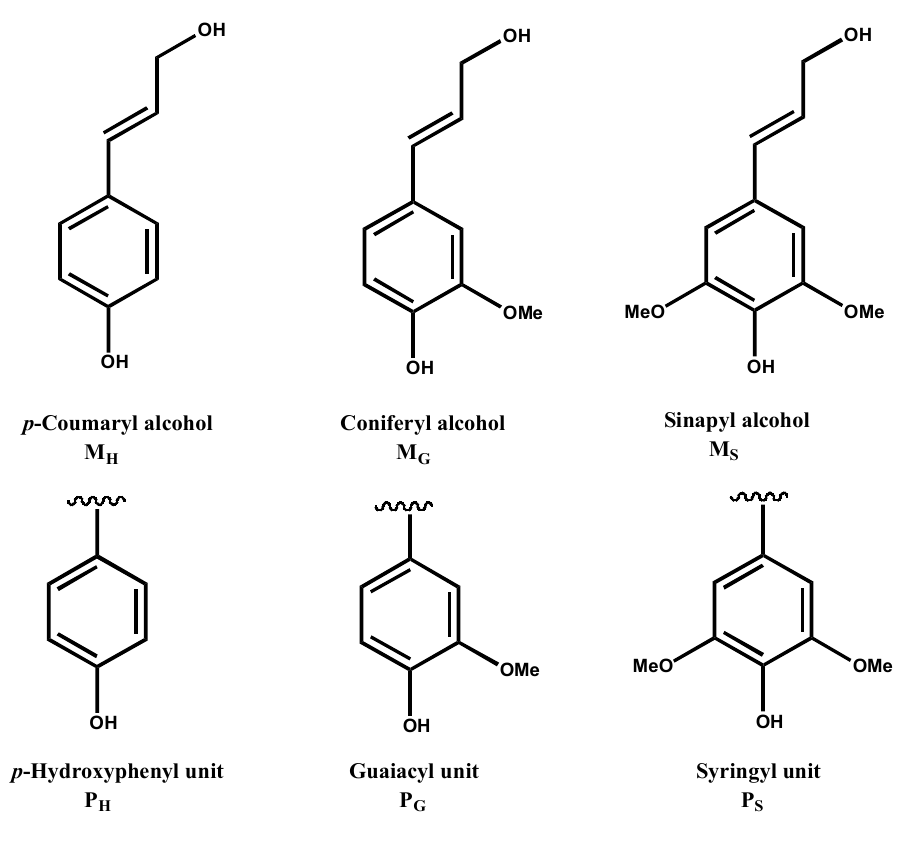
Figure 1. Lignin phenylpropanoid